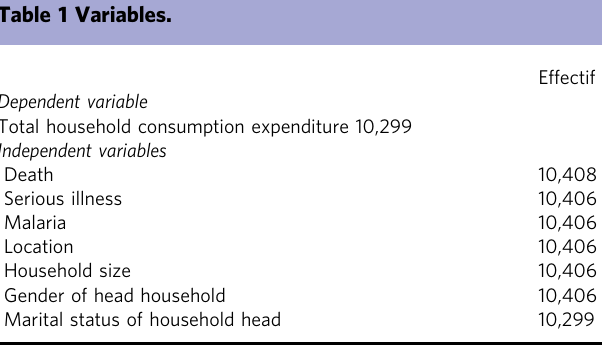
Table 1 Variables. Dependent